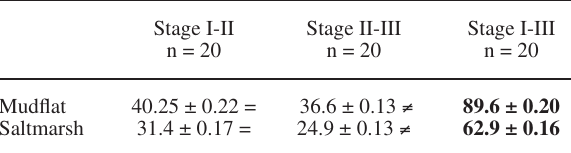
Table 3. – Neohelice granulata . Percentage egg loss and increase in egg volume during embryonic development, comparing mudflats and saltmarshes (mean ± Sd). The symbol ≠ indicates significant differences between successive values of the same habitat, while the numbers in bold indicate significant differences between habitats for the same value.